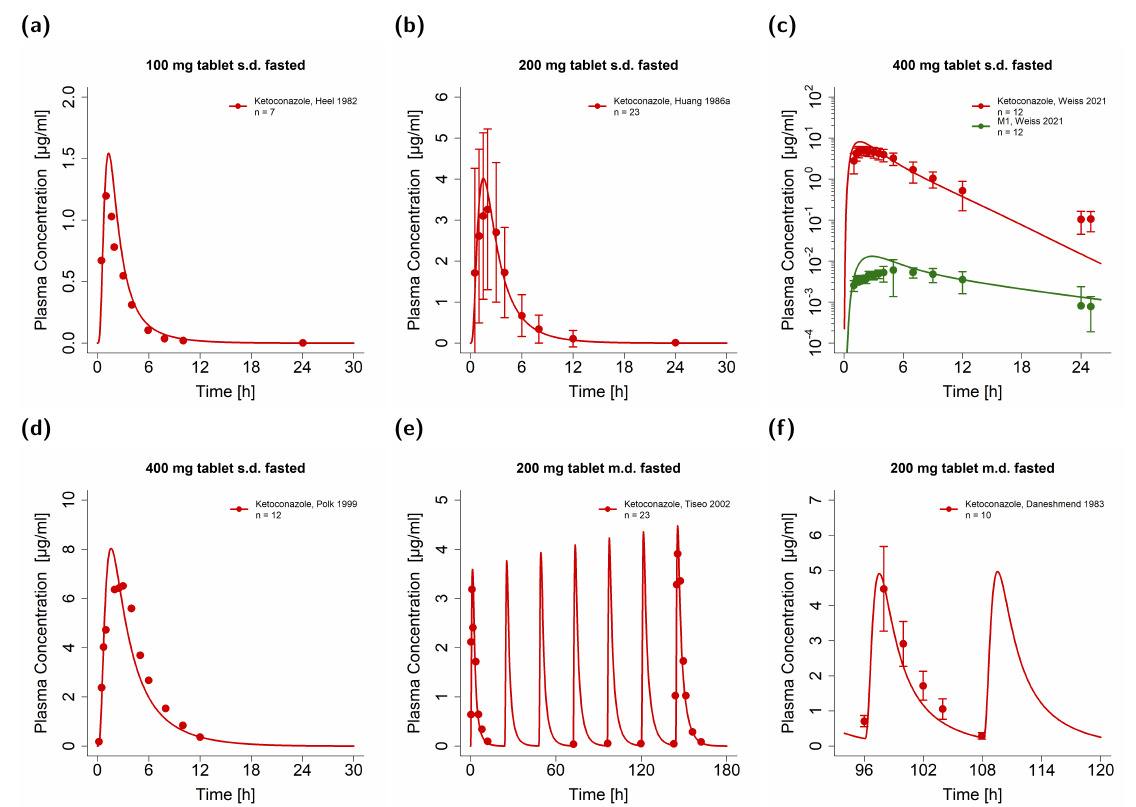
Figure 2. Graphical comparison of predicted and observed plasma concentration-time profiles of exemplary clinical trials of ketoconazole under fasted and fed conditions. ( a – d ) Single-dose administrations of tablets in fasted state with metabolite measurements; ( e , f ) multiple-dose admin- istrations of capsules and tablets in fasted state [1,13,44–48]. The model predictions are shown as solid lines and the corresponding observed data as dots (arithmetic mean ± standard deviation (if available)). Detailed information on study protocols is provided in Table S1.2 in the